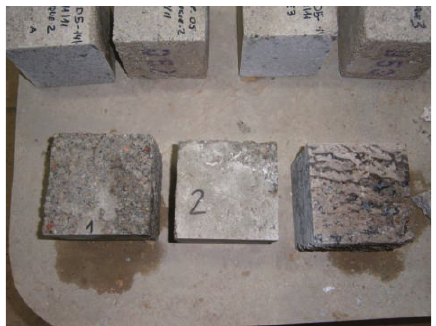
Figure 7: Specimens used for the compression